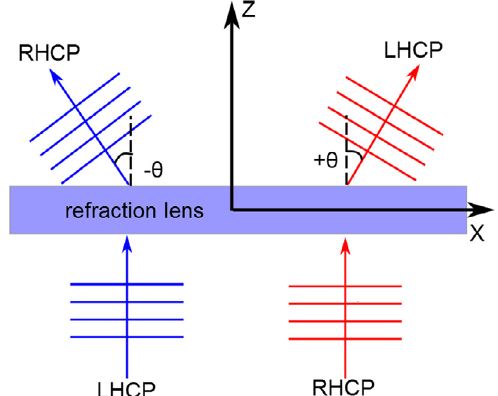
Figure 13. For a 1D refraction lens with phase gradient in the x -direction, the refraction angles for the transmitted plane waves are equal but opposite in sign for LHCP and RHCP incident